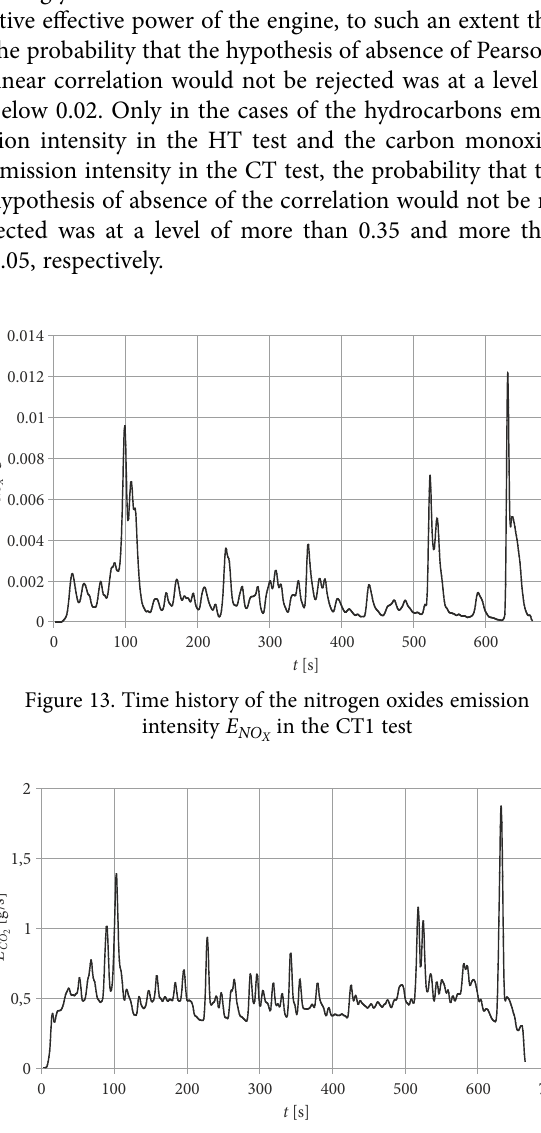
Figure 12. Time history of the hydrocarbons emission intensity E CH in the CT1 test